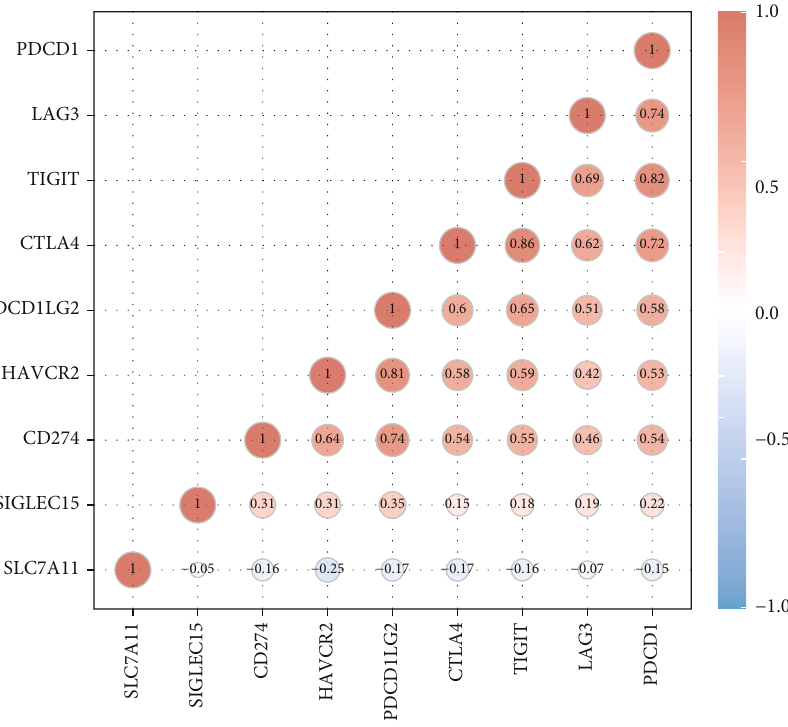
Figure 7: The association between SCL7A11 expression and several immune checkpoints in